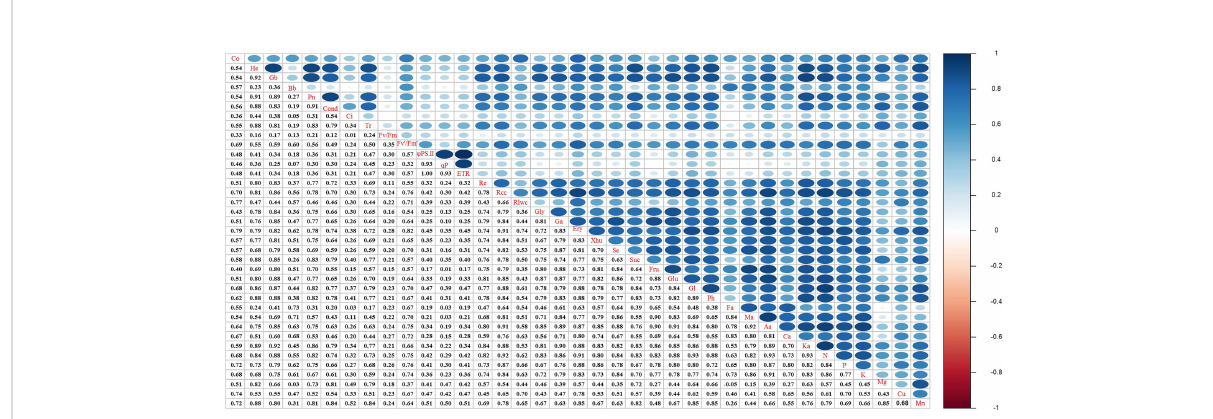
FIGURE 8 Effects of grazing rest during the spring regreening period on quantitative characteristics of degraded alpine meadow vegetation. Pn, Net photosynthetic rate; Cond, Stomatal conductance; Ci, Intercellular CO 2 concentration; Tr, Transpiration rate; Fv/Fm, Photochemical quantum ef fi ciency; Fv ’ /Fm ’ , Effective photochemical quantum ef fi ciency; j PSII, Actual photochemical quantum ef fi ciency; qP, Photochemical quenching coef fi cient; ETR, Electron transfer rate; Re, Respiratory rate; Co, Coverage; He, Height; Gb, Ground biomass; Bb, Belowground biomass; Rcc, Relative chlorophyll content; Rlwc, Relative leaf water content; Gly, DL-Glyceraldehyde; Ga, Glyceric acid; Ery, D-Erythrose; Xhu, Xylo-hexos-5- ulose; Se, Sedoheptulose; Suc, Sucrose; Fru, Frucose; Glu, Glucose; Gl, Glutamic acid; Ph, Phytol; Ba, Butanedioic acid; Fa, Fumaric acid; Ma, Malic acid; Aa, Aconitic acid; Ca, Citric acid; Ka, a -Ketoglutaric